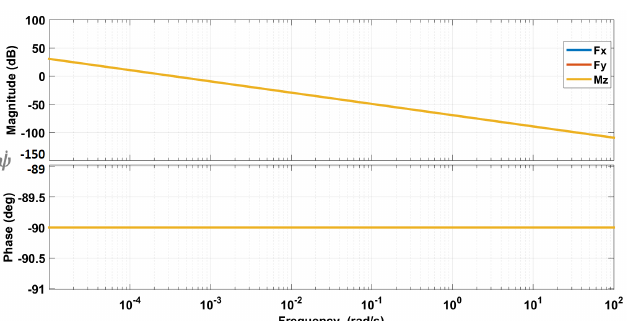
Figure 14. Bode diagrams for the lateral velocity [10].